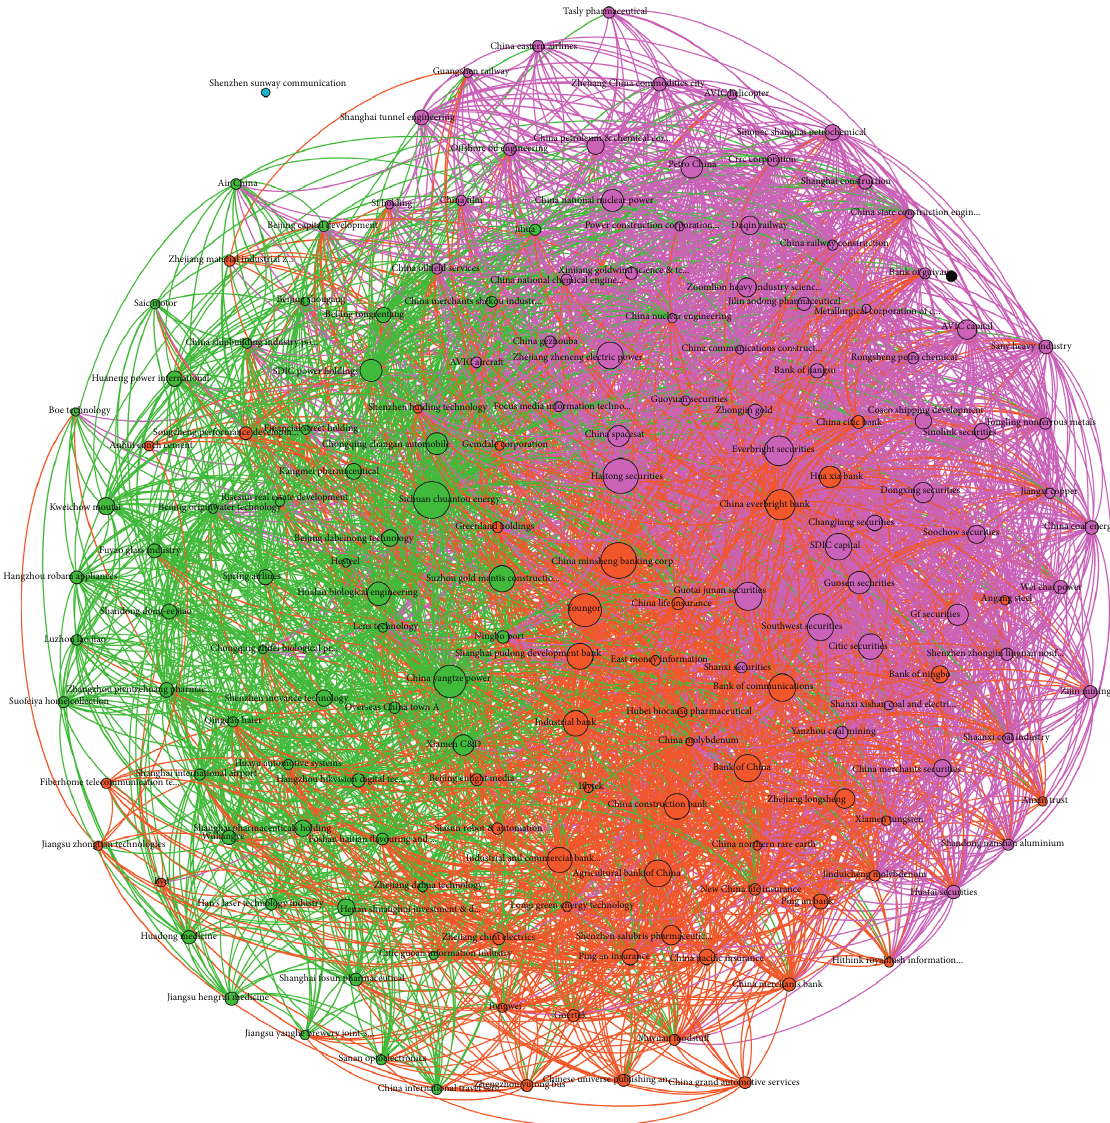
Figure 4: Complex network of CSI 300 during